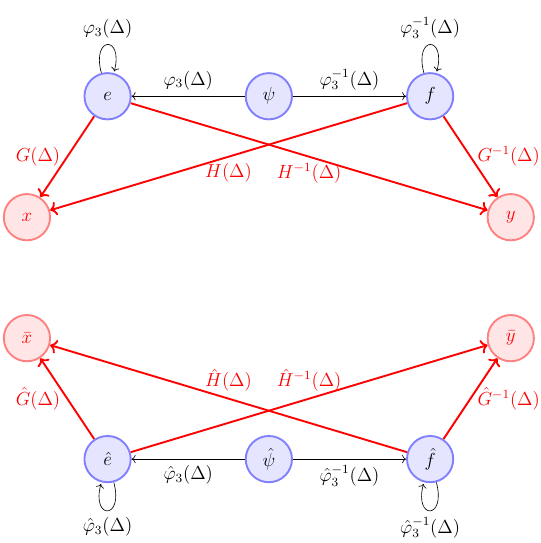
Figure 5 . OPEs of single box generators ( e; f ) with x and y , and those of the single hatted-box generators (^ e; ^ f ) with (cid:22) x and (cid:22) y .